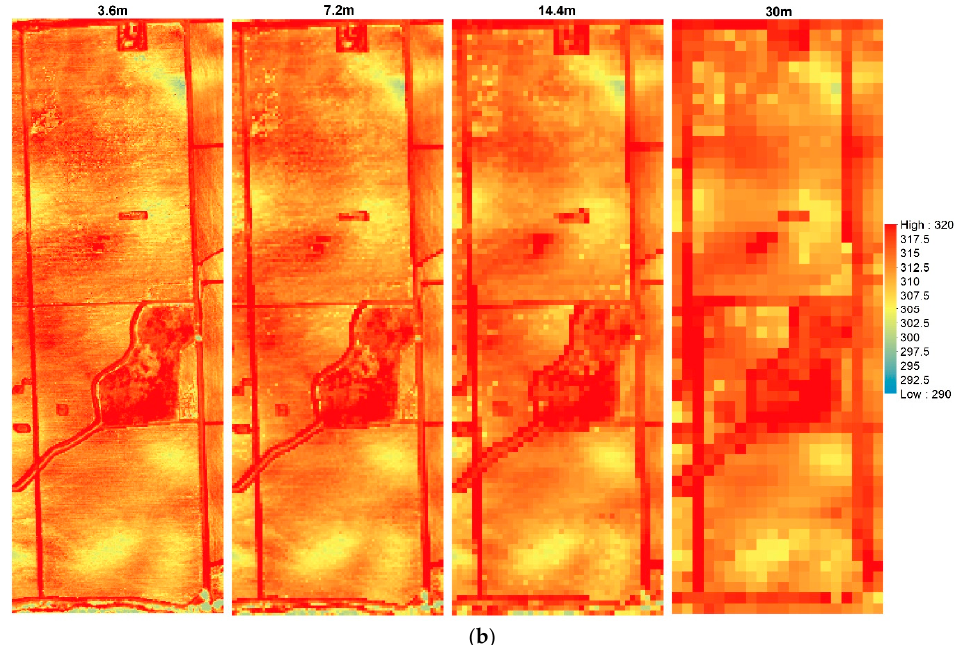
Figure 8. Example of ( a ) canopy temperature ( T c ) and ( b ) soil temperature ( T s ) in Kelvin (K) at different spatial domains for 09 August 2014.